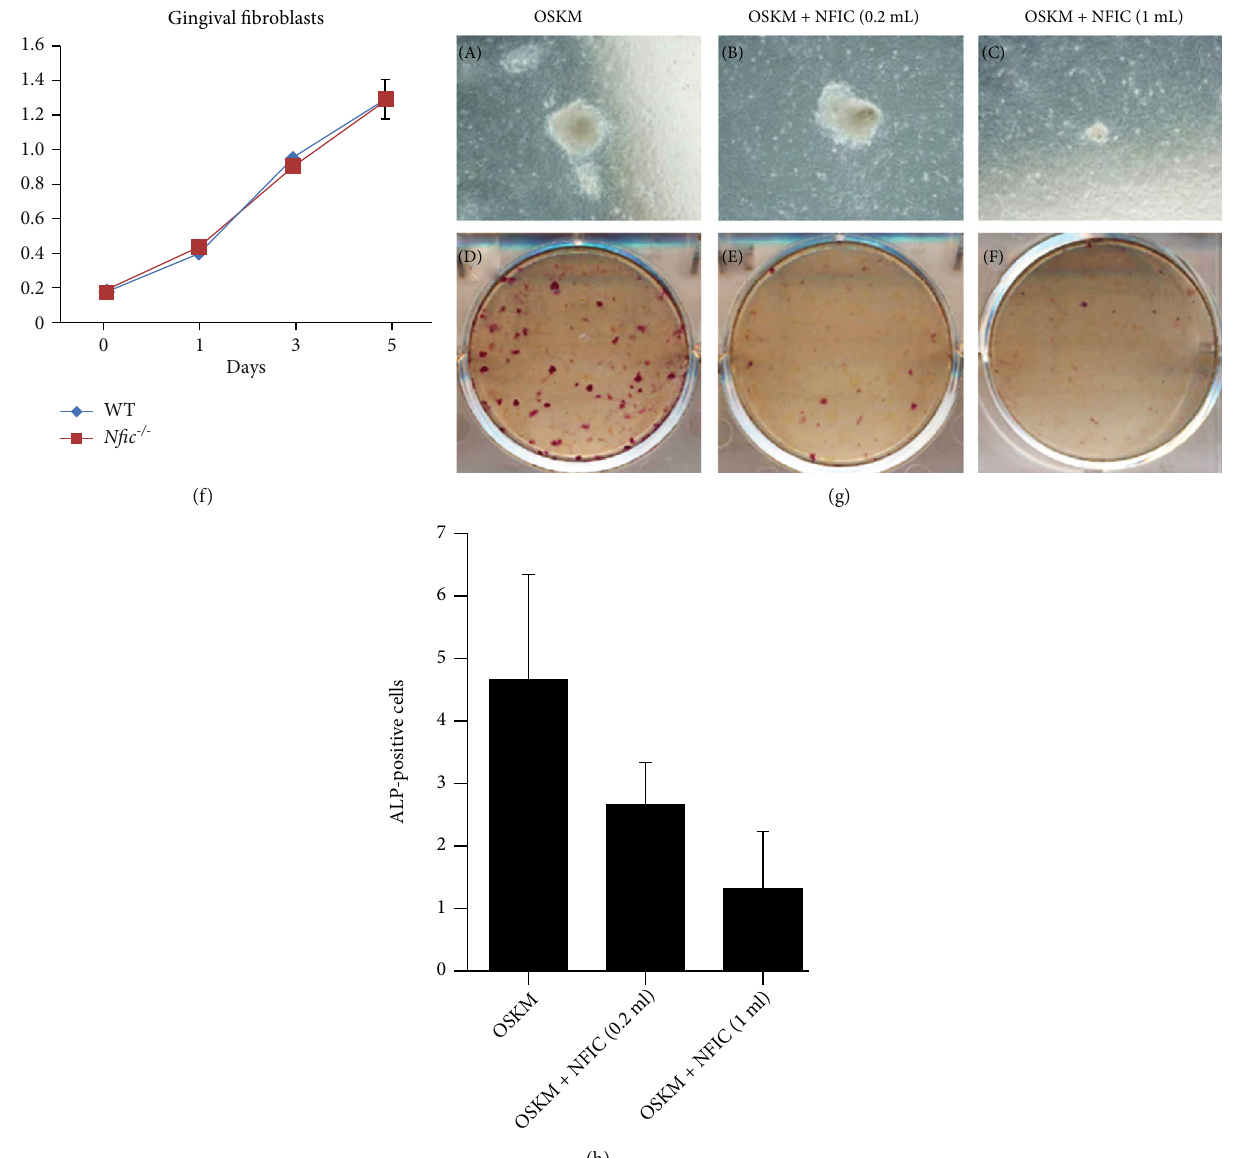
Figure 7: N fi c does not a ff ect Sox2 expression in soft tissues. (a) Sox2 mRNA and (b) protein expression levels were analyzed in primary cultured fi broblasts harvested from the tongues of N fi c -/- mice. (c) Immunohistochemistry (IHC) analysis of Sox2 expression in the tongues. (B) and (D) are higher magni fi cations of boxed (A) and (C). 6 weeks. Scale bars = ð A Þ , ð C Þ = 50 μ m ; ð B Þ , ð D Þ = 20 μ m . (d) Proliferation rate of tail, (e) gingival, and (f) dermal fi broblasts from N fi c -/- mice from day 0 to 5 compared to the WT. n = 5 , ∗ p < : 05 . (g) The number of ALP-positive colonies of iPSC from fi broblasts cultured in OSKM medium compared to the addition of N fi c in a dose-dependent manner. (A), (C), and (E) are higher magni fi cations of (B), (D), and (F), respectively. (h) Quantitative analysis of the number of ALP-positive colonies in various conditioned media. Data are presented as the mean ± SD . Abbreviations: ALP: alkaline phosphatase; Epi: epithelium; IHC: immunohistochemistry; iPSC: induced pluripotent stem cell; LaPr: lamina propria; OSKM, Oct4, Sox2, Klf4, c-Myc; OKM, Oct4, Klf4, c-Myc; SkMu, skeletal muscle; SqEp: squamous epithelium; WT: wild